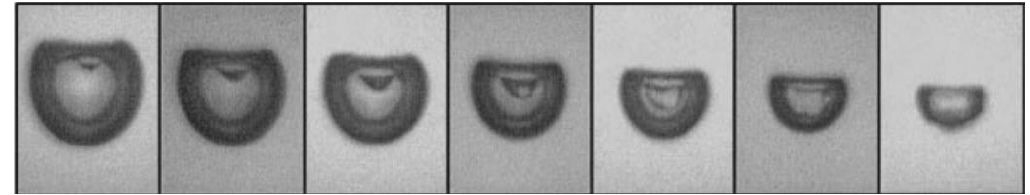
Figure 5. Experimental images: λ = 2.5, 𝑅 0 = 1.45 × 10 −3 m .